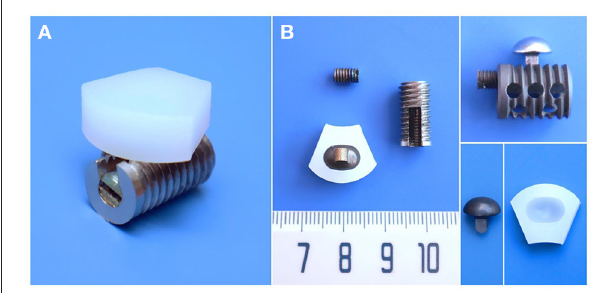
FIGURE 1 | Structural design and material specifications of cervical subtotal discectomy prosthesis (CSDP). (A) Oblique views of the assembled CSDP. (B) The CSDP consists of cervical disc prosthesis (CDP) structure, cervical vertebra fixation (CVF) structure, link structure, and locking screw. The link structure constitutes the ellipsoid-in-socket articulation with the CDP structure and is fixed on the CVF structure by the locking screw.